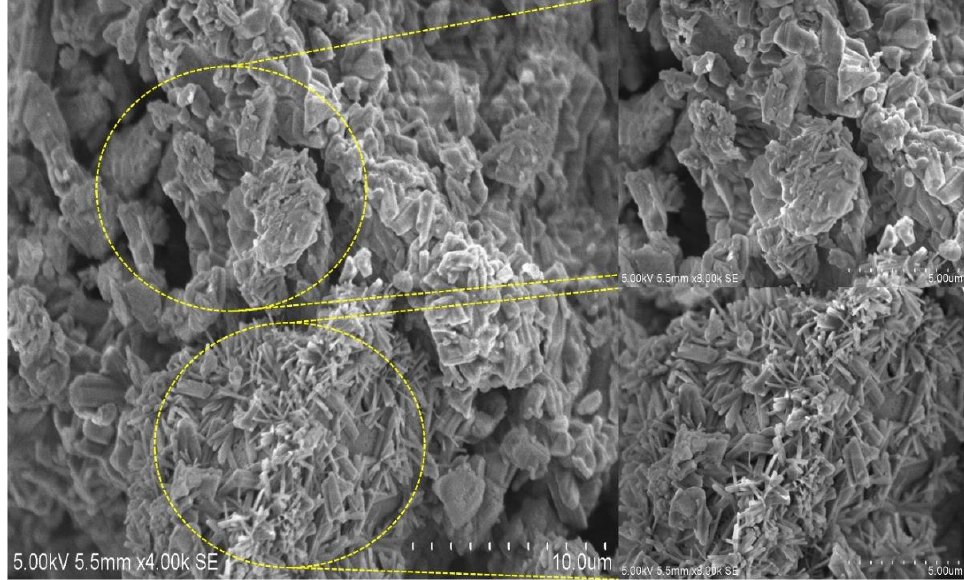
Figure 5. SEM image of the synthesized PFSS.